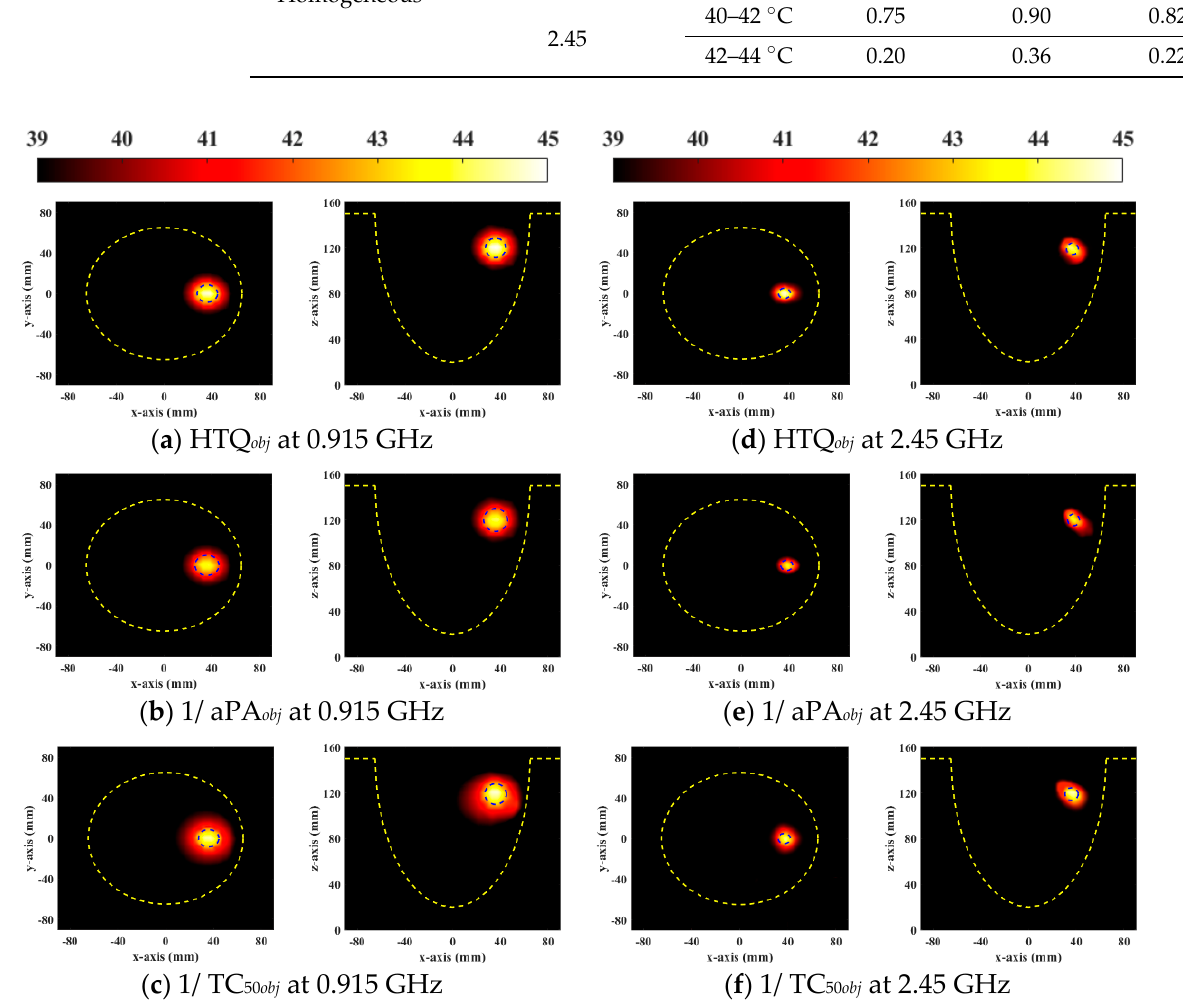
Figure 8. Steady-state temperature distribution in axial (XY) and coronal (XZ) planes of a general breast model optimized by each objective function used in DE.